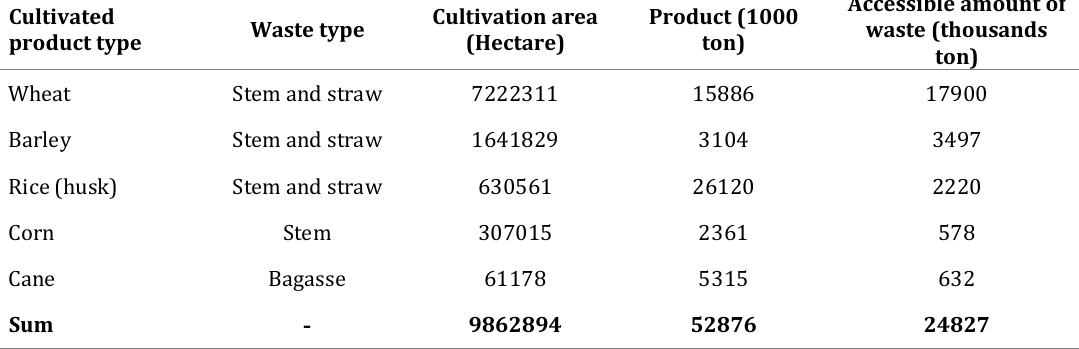
Table 2- The cultivation waste production in Iran during 2007-2008